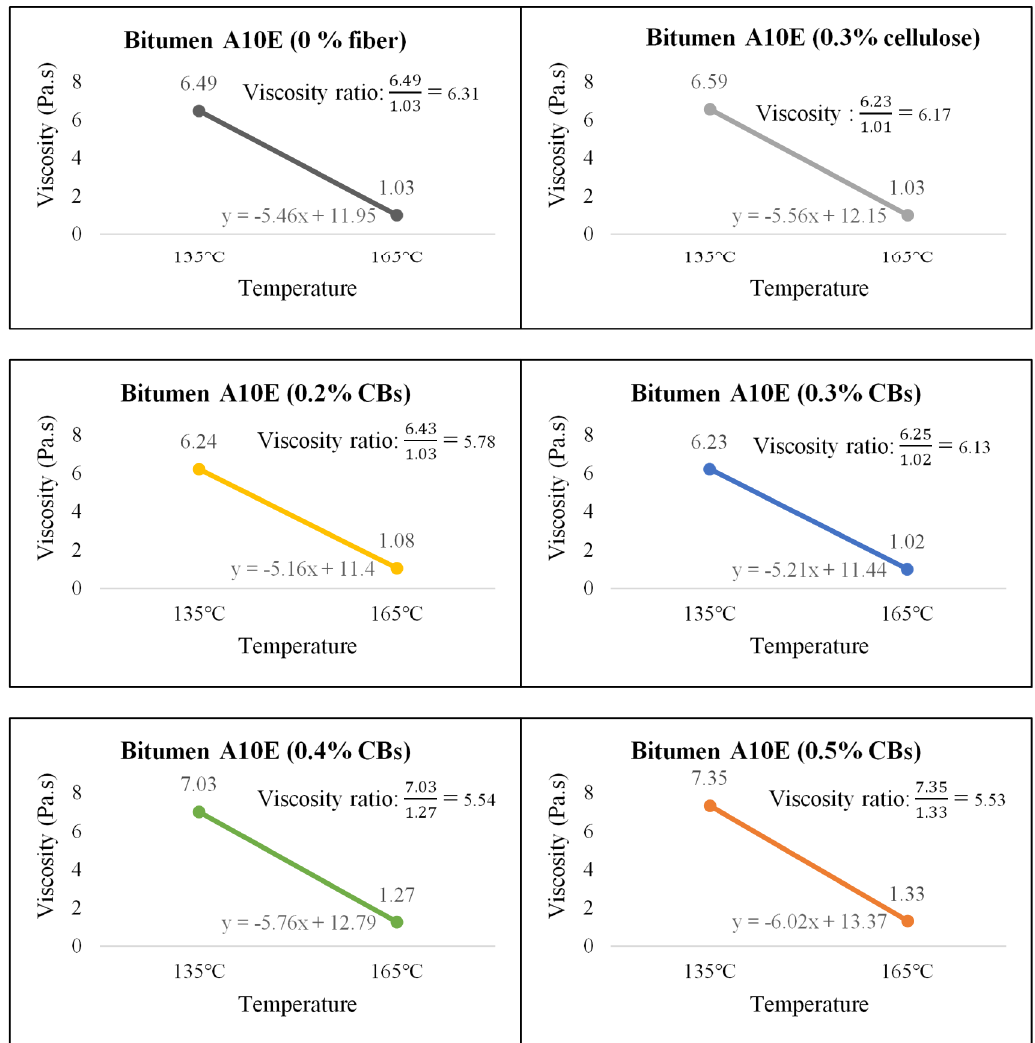
Figure 13. Viscosity ratio and slope of Bitumen PMB A10E with cellulose fiber and di ff erent % of CB content.